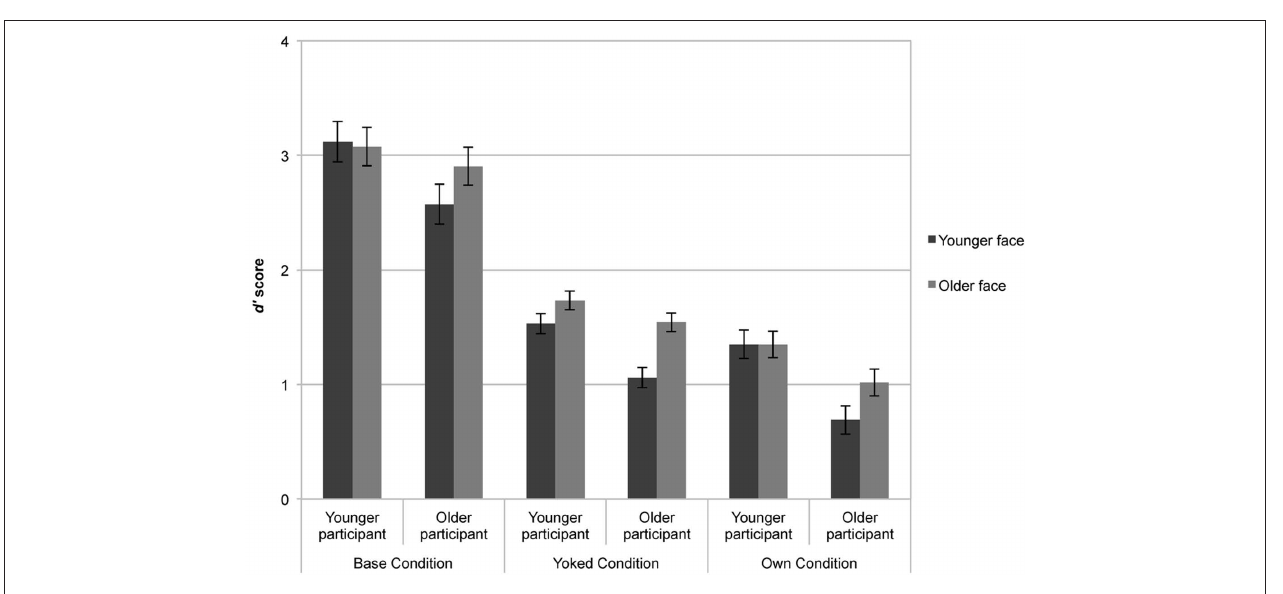
viewing was restricted by a moving window (i.e., yoked, own). Yoked participants were more accurate than own participants who were in control of the moving window. The own-age recognition bias for older adults (higher accuracy for older versus younger faces) was observed regardless of viewing